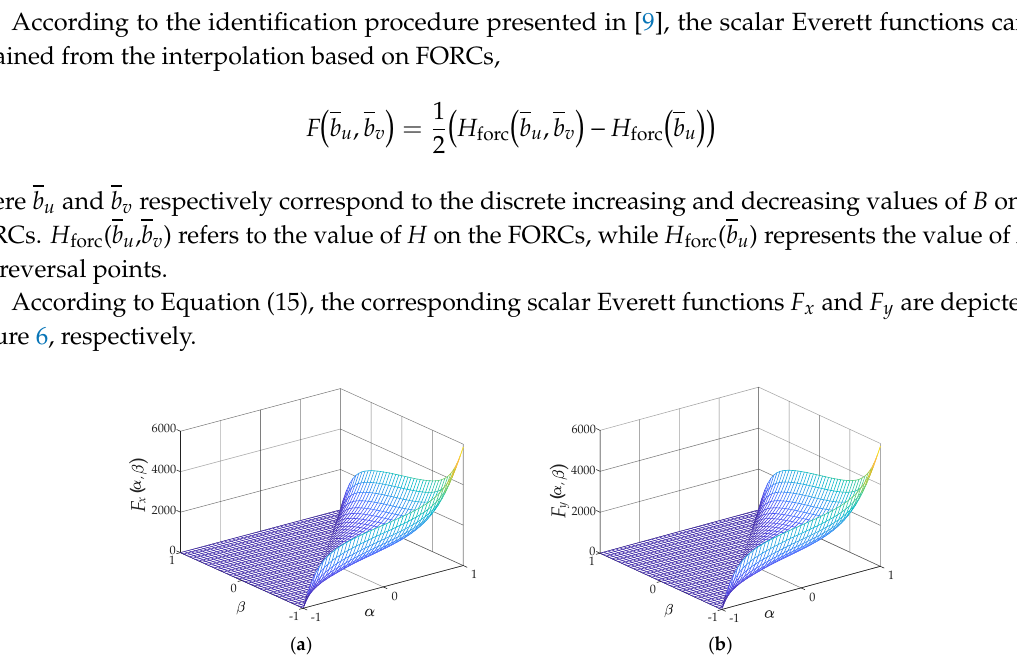
( b ) Figure 7. Normalized inverted scalar Everett function F and vector Everett function E : ( a ) Function F ; ( b ) Function E . 0 15000